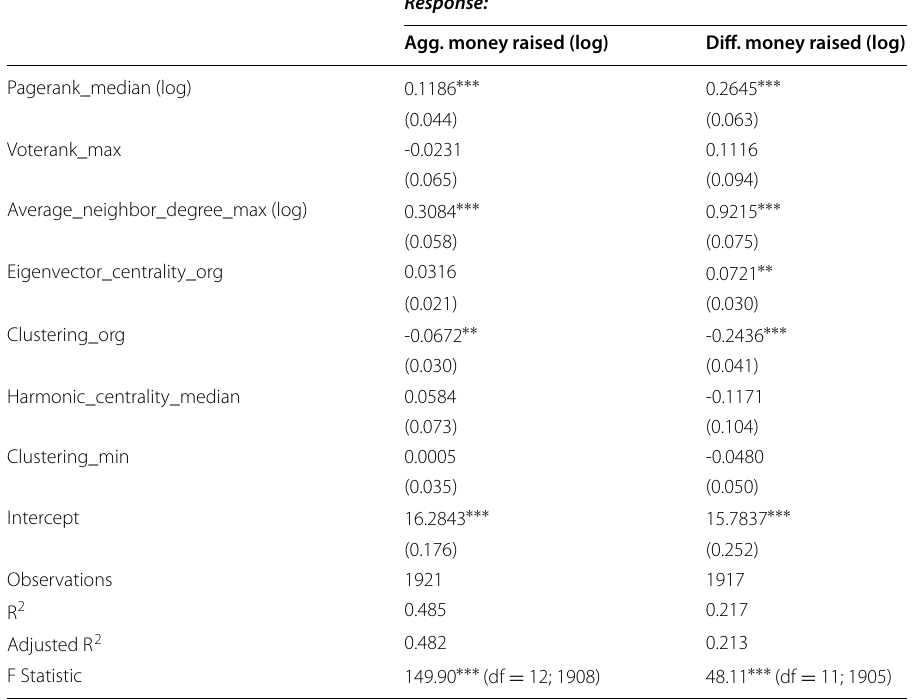
Table 3 Linear regression